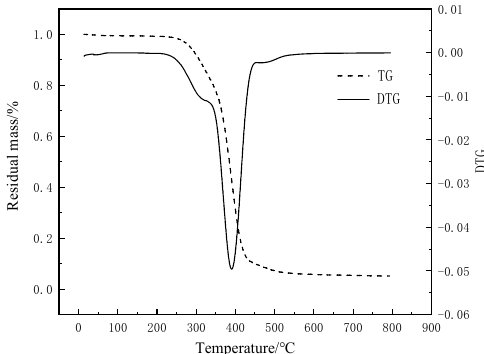
Figure 10. T26 polyurea TG and DTG curves.